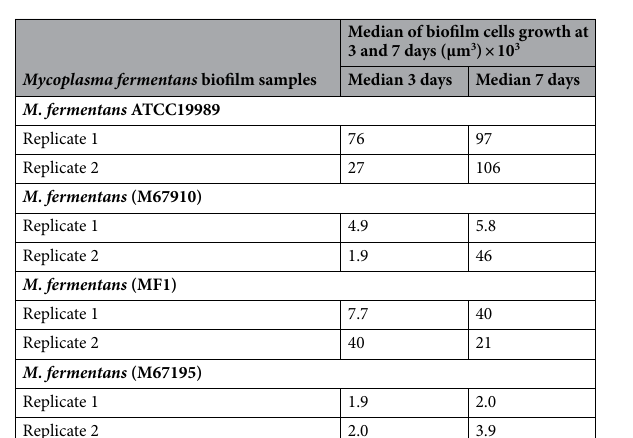
Figure 4. Three-dimensional visualisation confocal images of biofilm structure formed by Mycoplasma fermentans ATCC19989 after 3 days ( a , b ) and 7 days ( c , d ) termed late growth stage. Overhead views in ( a , c ) and side views for the early and late growth stage seen in ( b , d ). The lateral dimension of each confocal image was 238 microns × 238 microns. Arrows indicate the examples of tower structures in both early and late stage biofilm growth (Amira ver 5.4 https:// www. therm ofish er. com/ uk/ en/ home/ indus trial/ elect ron- micro scopy/ elect ron- micro scopy- instr uments- workfl ow- solut ions/ 3d- visua lizat ion- analy sis- softw are. html, https:// www. vsg3d. com).